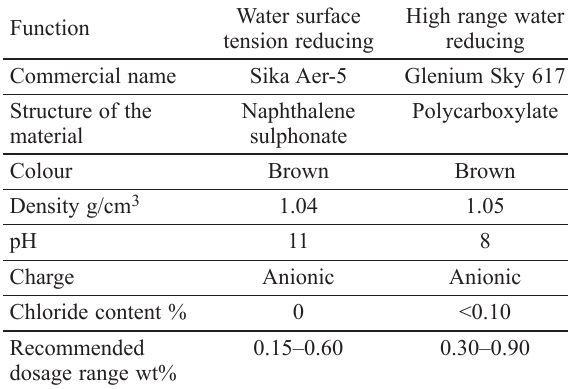
Table 3. Characteristic of